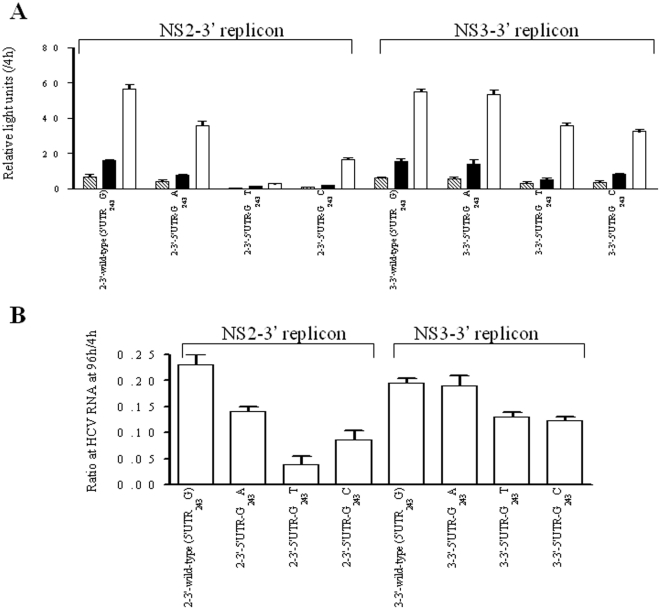
Transient-replication assay of the NS2-3′ and NS3-3′ replicons.The replicons each carried wild-type (5′UTR243G), 5′UTR-G243A, 5′UTR-G243T and 5′UTR-G243C. Huh-7 cells were transfected with 2.5 µg of replicon RNA. (A) Luciferase activity was determined in cell lysate at 48 h (stripe), 72 h (black) and 96h (white) posttransfection. Data were normalized by the values at 4 h posttransfection, expressed as mean ± SD (n = 4). (B) HCV-RNA was quantified by real-time PCR at 96 h posttranfection. Data were normalized by the values at 4 h posttransfection, expressed as mean ± SD (n = 3).